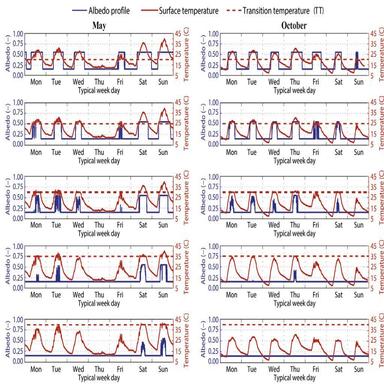
Albedo profile for two representative weeks in May (left) and in October (right), for the five considered transition temperatures, i.e. from top to bottom TT = 20, 25, 30, 35 and 40 °C.